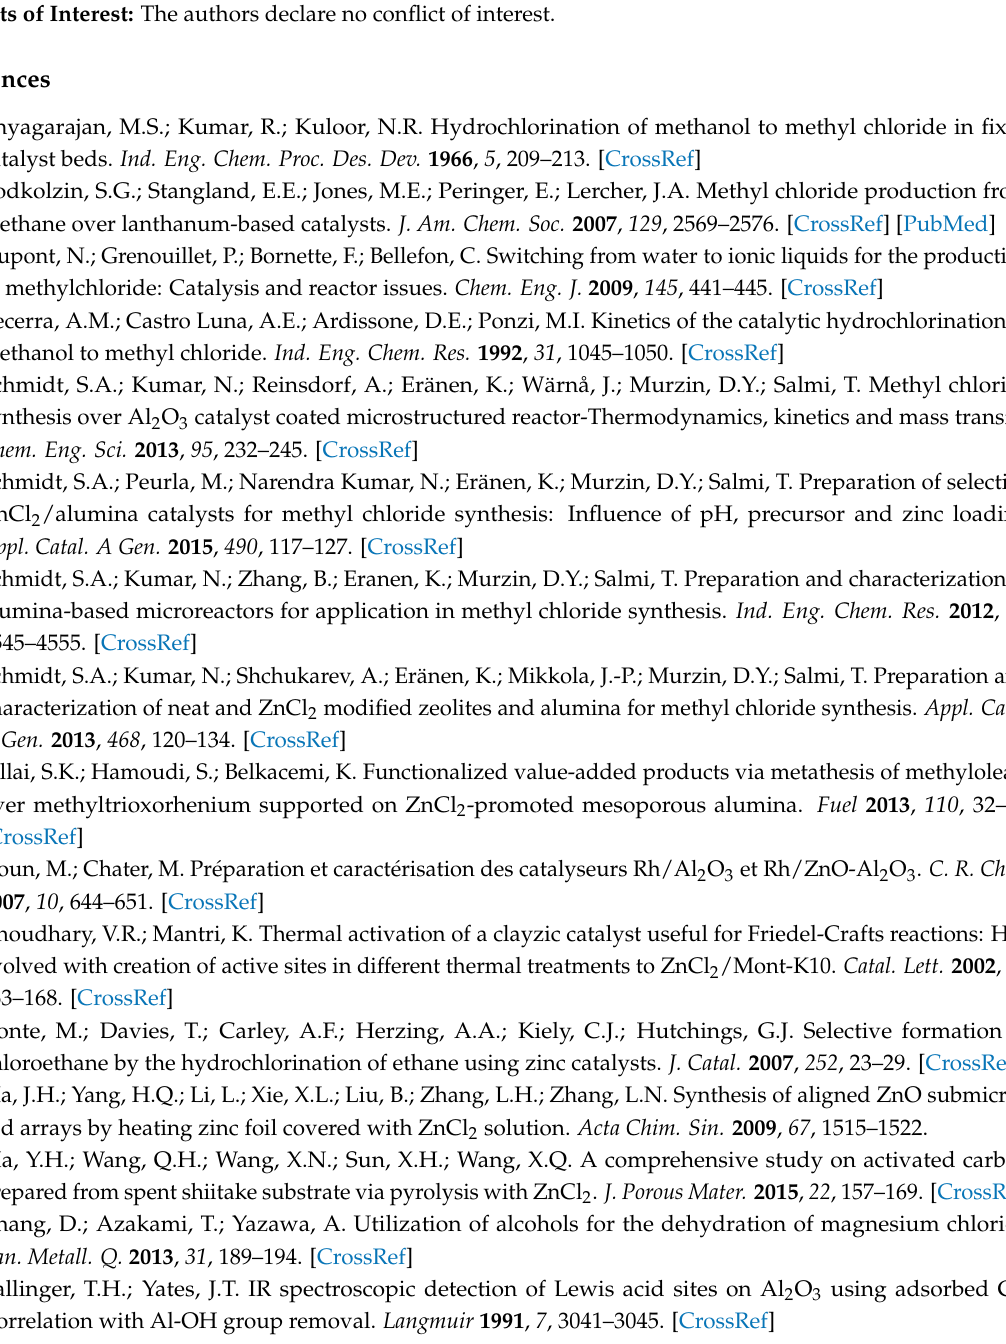
Figure S1: FTIR spectra of pyridine adsorbed on mesoporous aluminas and metal chlorides modified aluminas. Spectra are on the same scale and offset vertically for